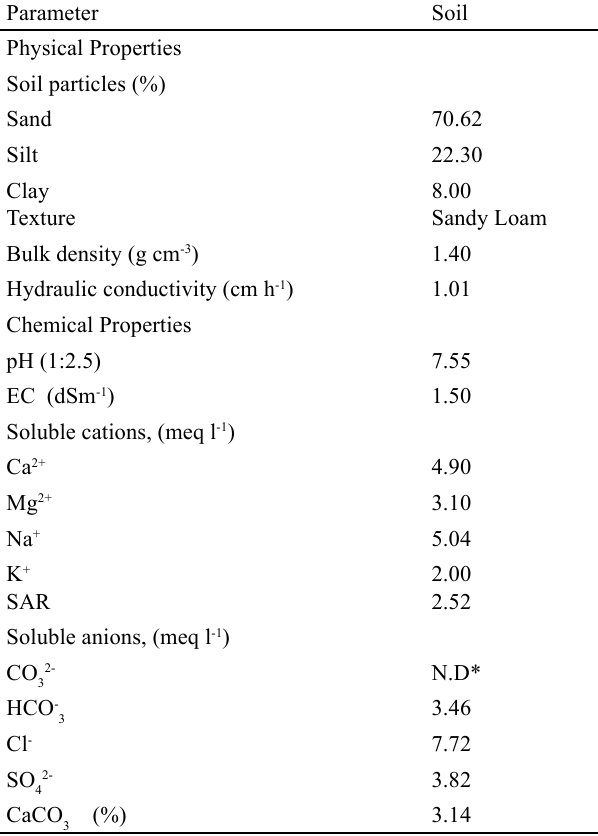
Table 1 . The soil charactersitics of the nesting